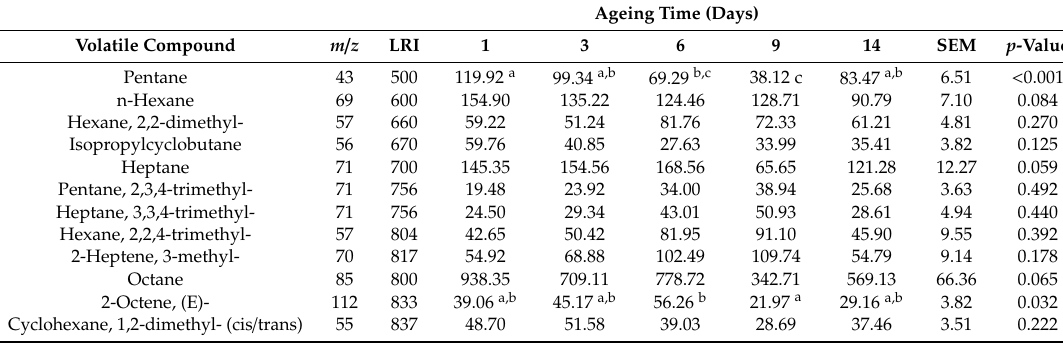
Table 2. E ff ect of aging time in the hydrocarbons content, expressed as quantifier area units (AU × 10 3 / g), of donkey meat steaks aged for 14 days under vacuum conditions ( n = 10 samples for each aging time). Ageing Time (Days) Volatile Compound m / z